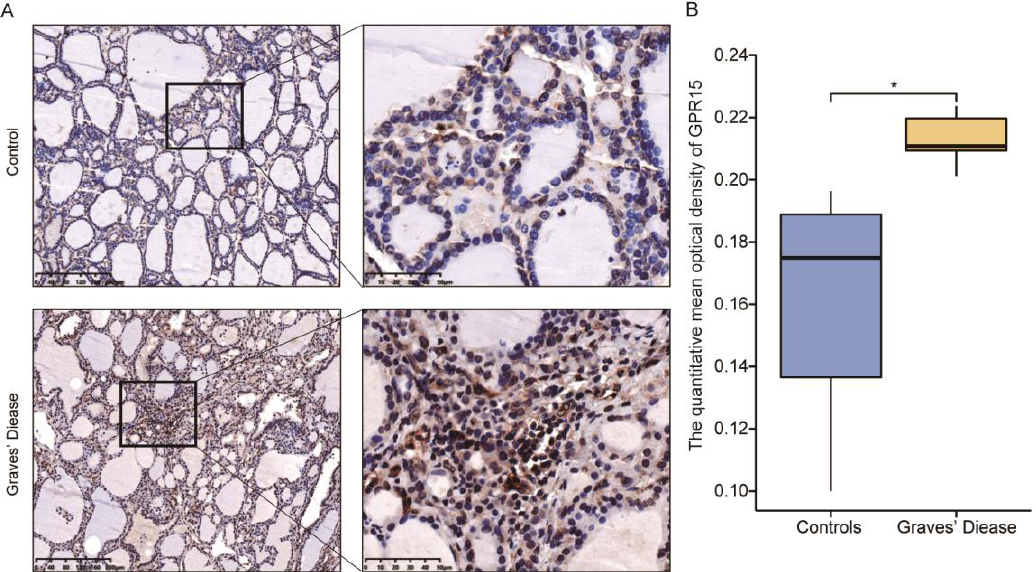
Figure 4. GPR15 levels were raised in thyroid tissue from GD. ( A ) Represents Immunohistochemical results of GPR15 of thyroid tissue specimens. ( B ) Statistical analysis of Immunohistochemical results. (GD = 5, Controls = 5). (*, p <